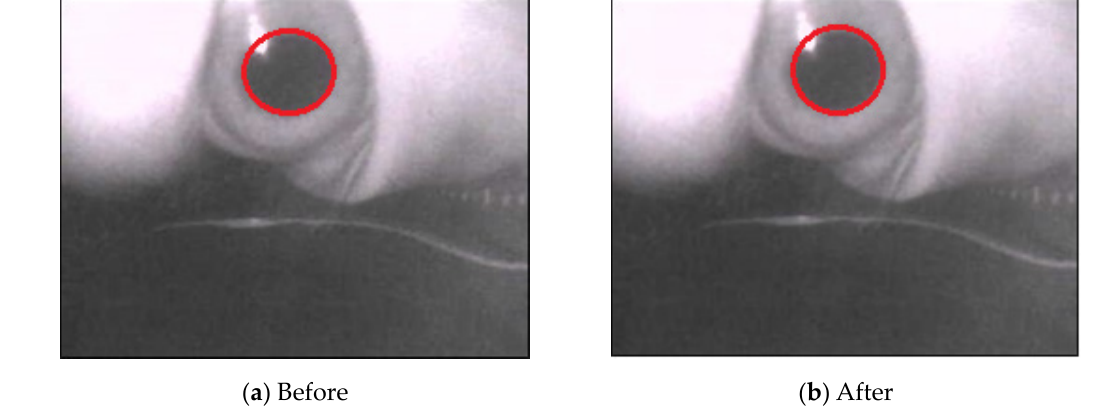
Figure 12. Results of distortion correction.